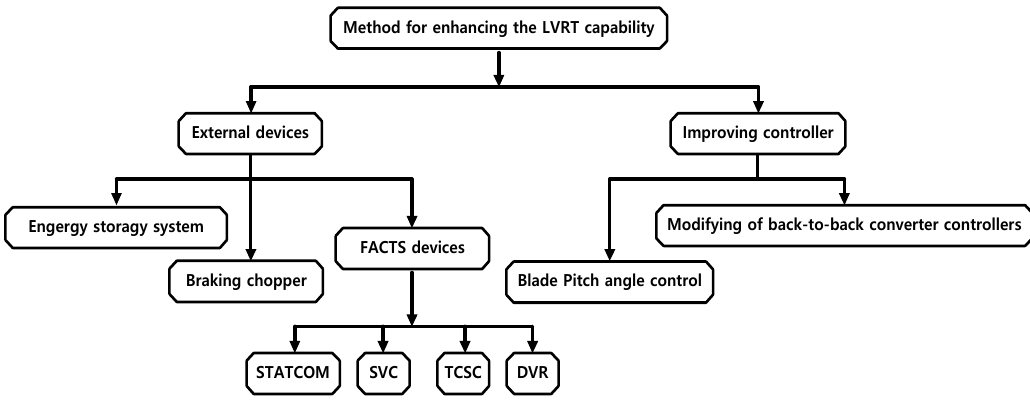
Figure 3. Conventional method for enhancing LVRT